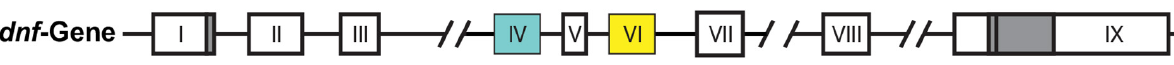
FIGURE 2 | Schematic drawing of the rodent Bdnf gene, which is composed of eight non-coding exons (I–VIII) that are individually transcribed and alternatively spliced to the protein-encoding exon IX. Bdnf exon IV and VI are directly or indirectly regulated by changes in neuronal activity. In BDNF-Live-Exon-Visualization (BLEV) mice (Matt et al., 2018; Singer et al., 2018b), BDNF exon IV and VI are individually labeled with either cyan (exon IV) or yellow (exon VI) fluorescence protein in regions of activity-dependent translation of BDNF. Modified after (Aid et al., 2007; Singer et al., 2018b).